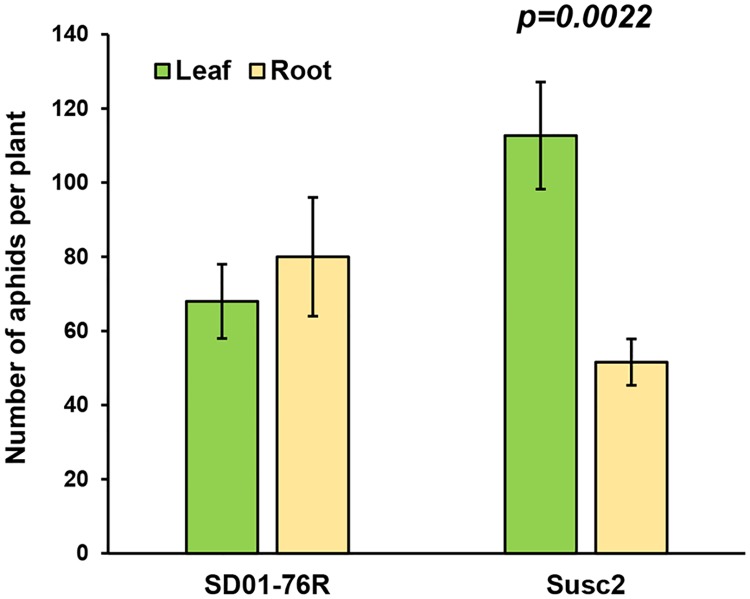
Aphid performance on hairy roots and full soybean plants.Ten aphids were introduced to each plate with one cotyledon and hairy root system, or to the V3 leaf of a soybean plant. After one week, aphid numbers were recorded. Two different aphid-susceptible soybean cultivars were tested, SD01-76R and Susc2. Two independent experiments with 10 replicates for each cultivar and treatment were carried out. Comparison of aphid performance on roots and leaves of each cultivar was performed using Student’s t-test. Error bars = standard error.